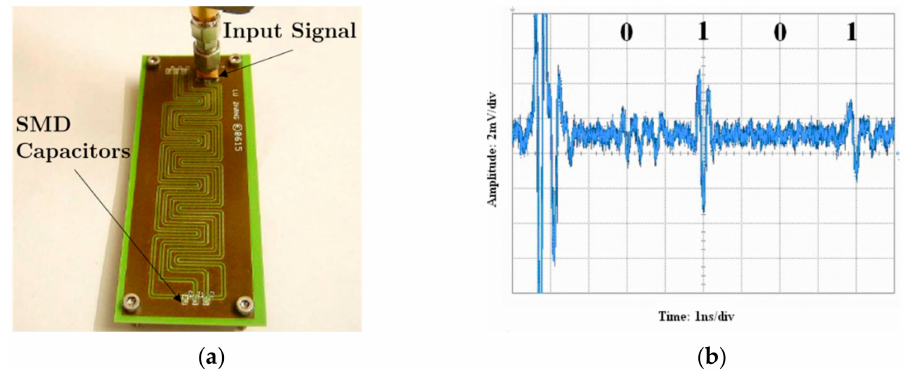
Figure 3. ( a ) Photograph of the chipless-RFID tag proposed by Zhang et al. (code ‘0101’); ( b ) measured code ‘0101’. Figure extracted from [21].